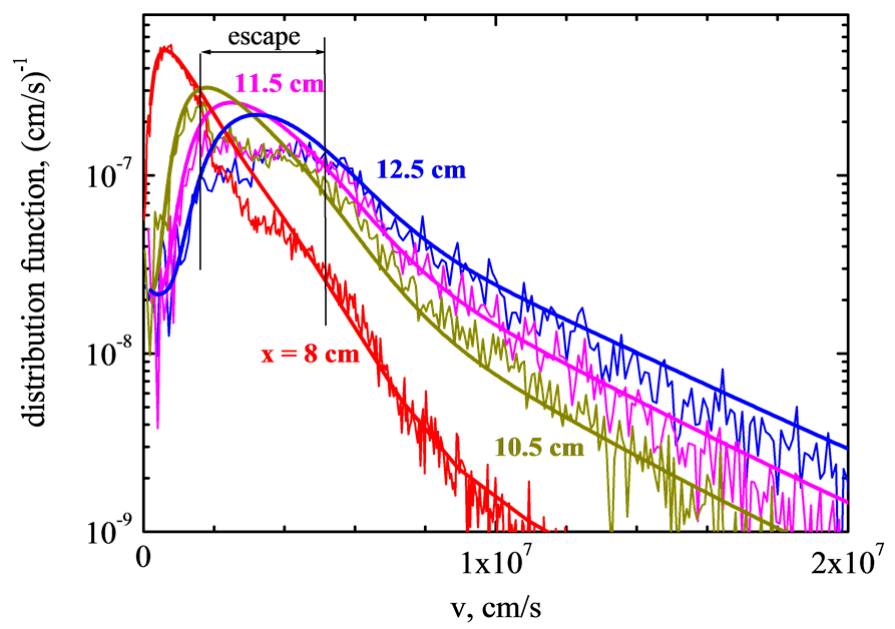
Figure 6. Atomic velocity distribution function at large distances from the wall at the outer horizontal chord: thick solid lines-ballistic model, thin lines-MC modeling with the EIRENE